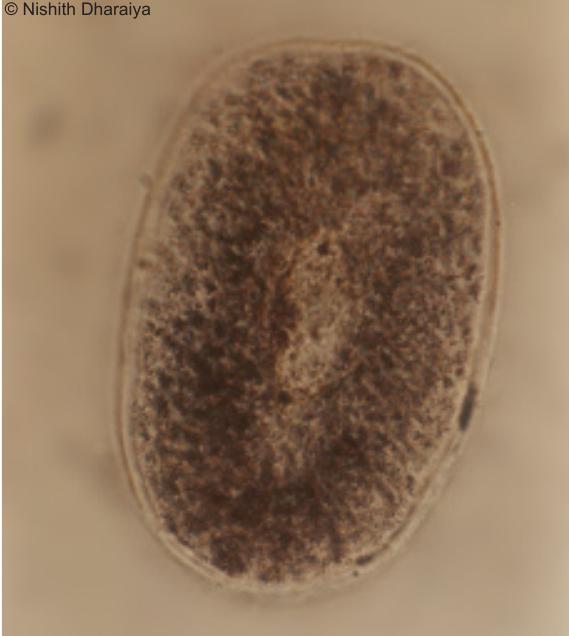
Image 6. Cross section of hair of Domestic Goat